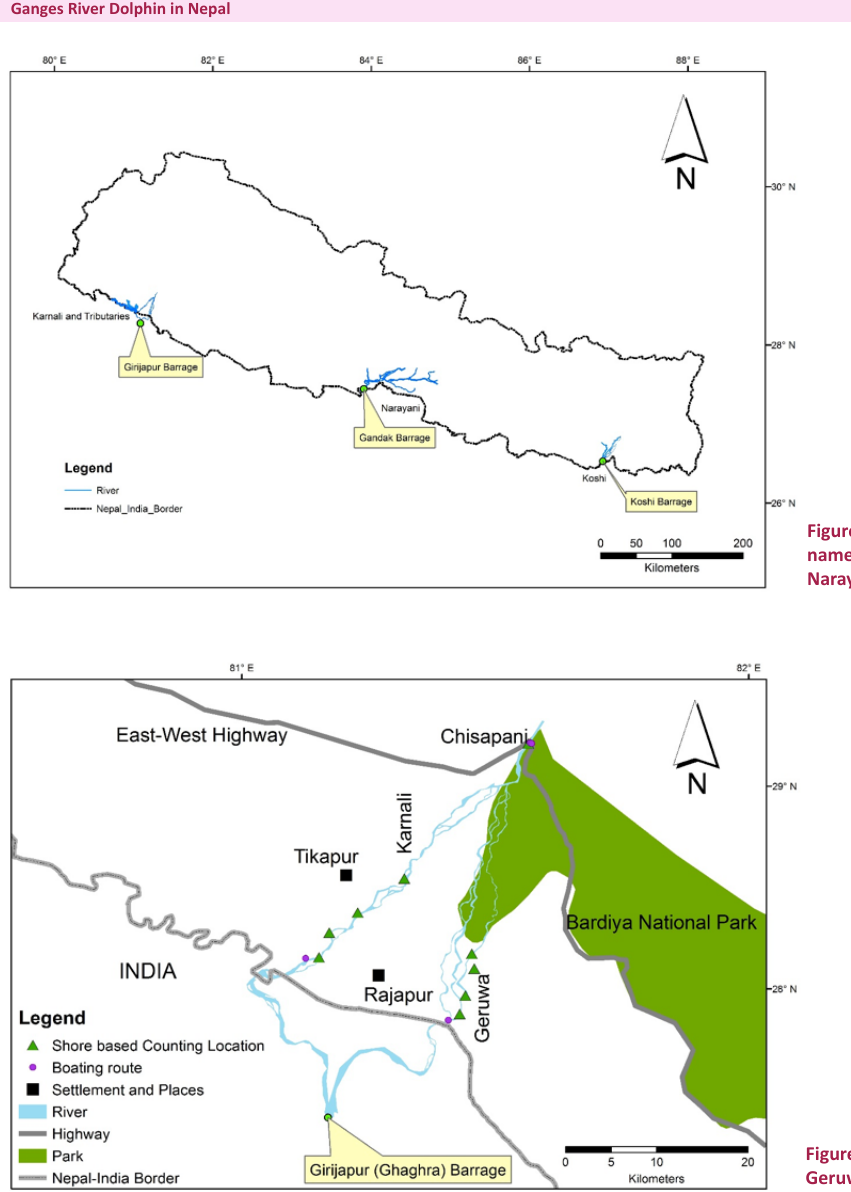
Figure 2. The surveyed areas in Karnali and Geruwa rivers,